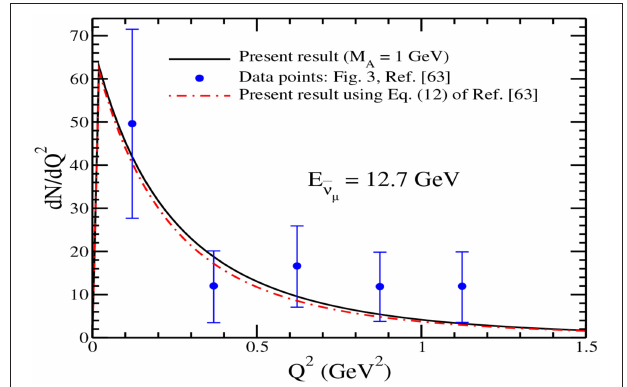
FIGURE 5 | Comparison of present results for the Q 2 distribution with the results given in Figure 3 of Ammosov et al. [63]. Solid line represents the present results using M A = 1 GeV, dashed-dotted line represents the present results obtained using Equation (12) of Ammosov et al. [ 63] and the data points are taken from Ammosov et al. [ 63]. σ TABLE 2 | Flux averaged cross section (using Equation 63), longitudinal h i P P and perpendicular components of polarization(using Equation 64) are given h i ν µ p µ + 3 for the process ¯ →